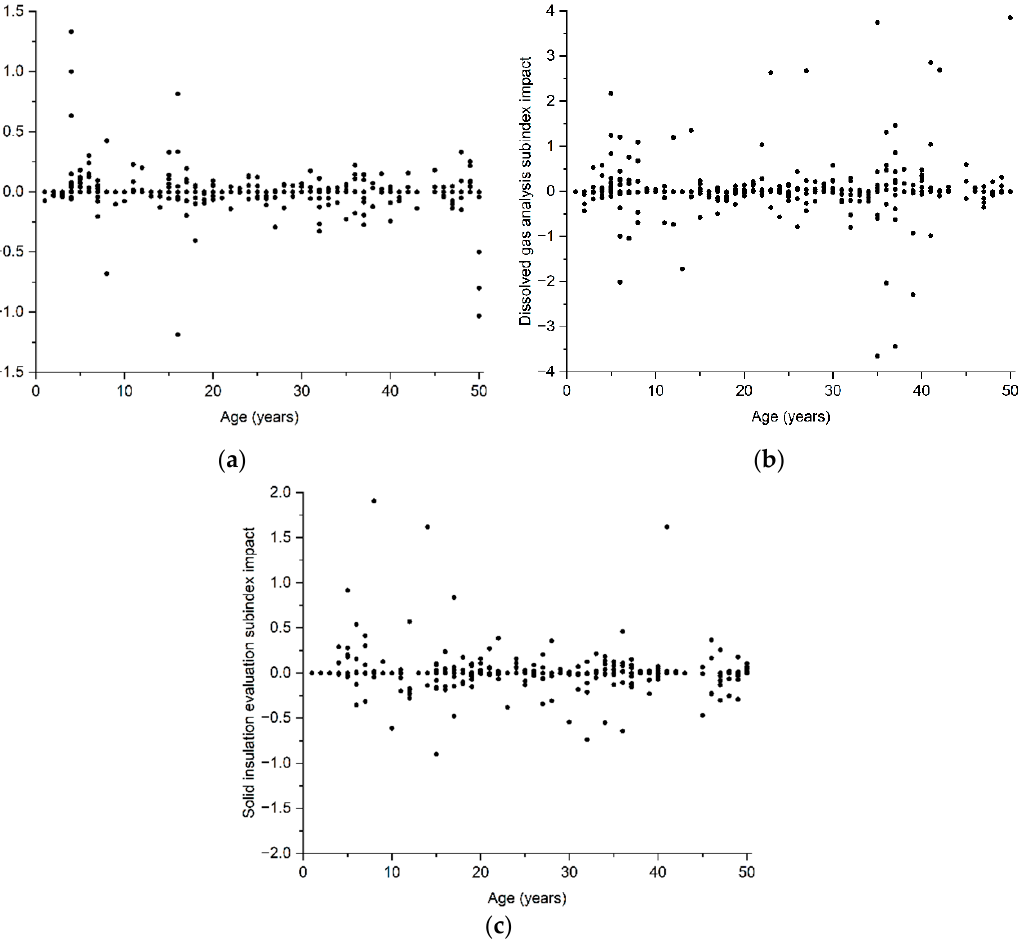
Figure 5. The annual changes in the subindex values between successive tests: ( a ) HI OIL ; ( b ) HI DGA ; ( c ) HI ISO .